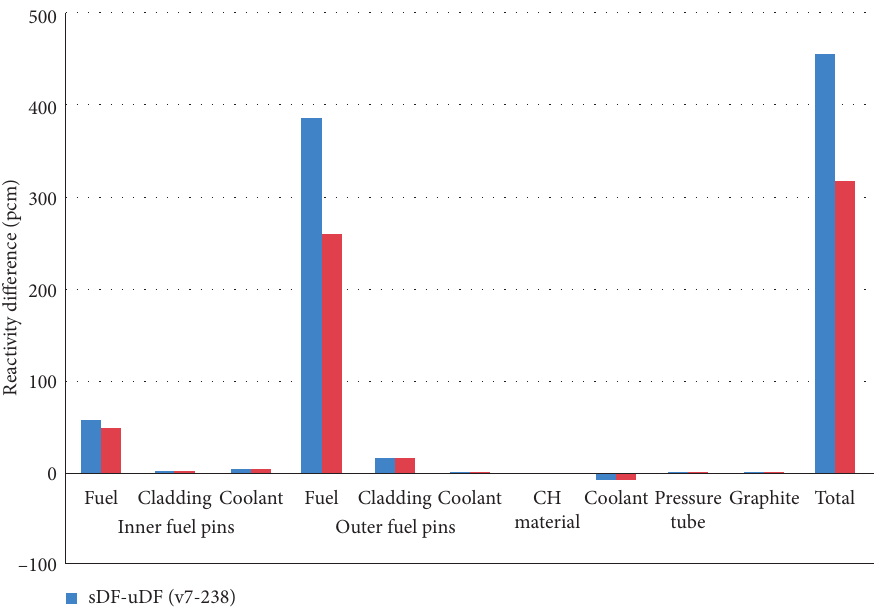
Figure 5: Δ ρ sDF-uDF for separate geometry